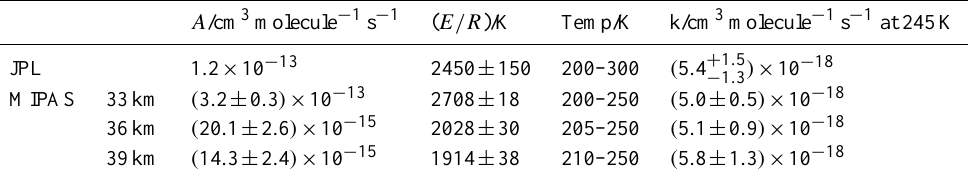
Table 2. Table summarising the MIPAS observations of k in comparison to the JPL recommendation for Reaction R2 (NO 2 + O 3 NO 3 + O 2 ). The values for the pre-exponential parameter ( A ) and the activation temperature ( E/R ) are derived from the data shown in Figs. 7–9 at 33, 36 and 39km. The value of the reaction rate at 245K is shown for all cases.